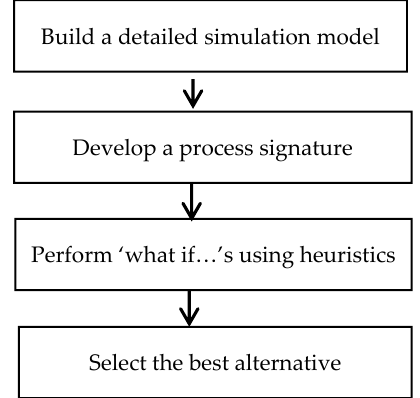
Figure 11. Steps in simulation based scheduling methodology.